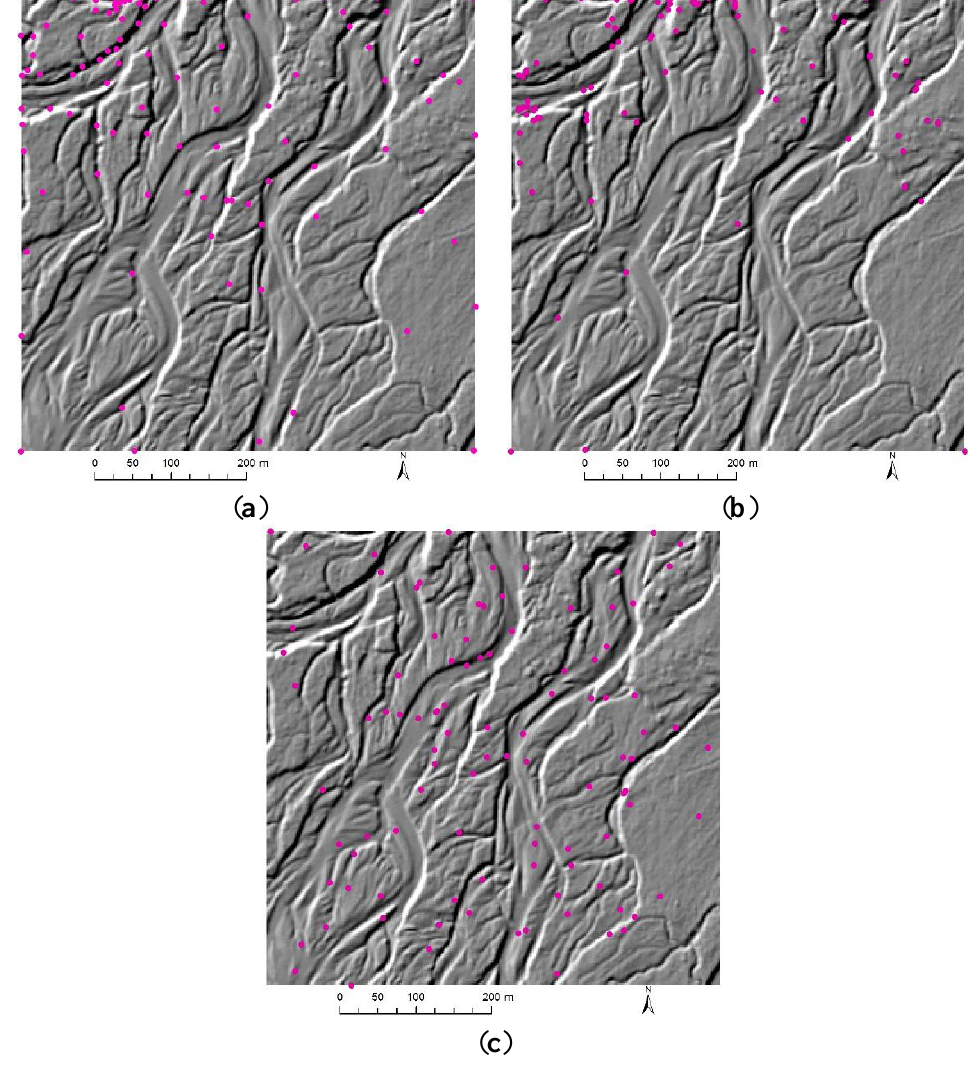
Figure 2. Distribution of the 100 critical points selected by ( a ) TPS-based algorithm, ( b ) max-Z and ( c ) the random method in the flat